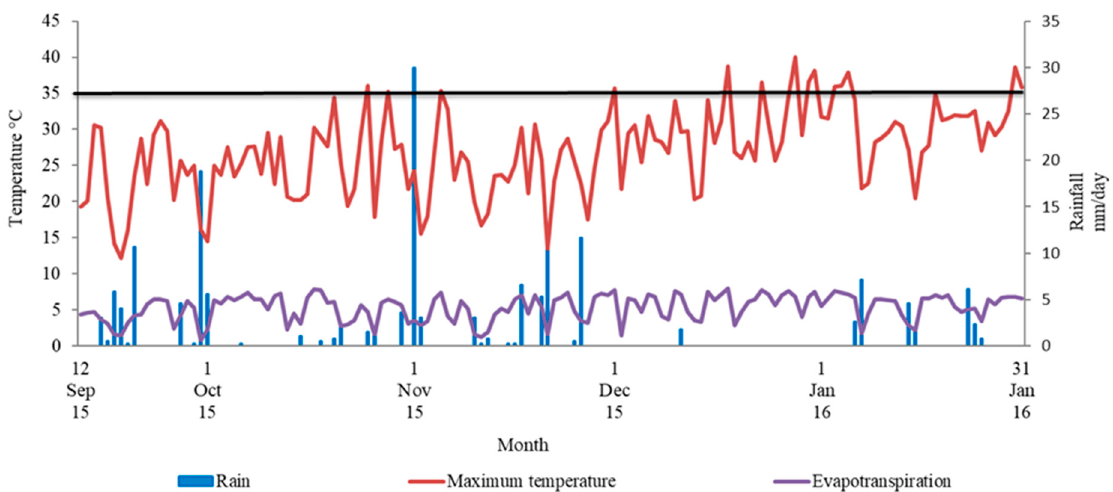
Figure 1. Maximum temperature, rainfall and evapotranspiration from September 2015 to January 2016 at the University of Fort Hare Research Farm, Alice, South Africa. Quality protein maize inbred lines (Table 1) obtained from Quality Seeds (PTY) LTD, South Africa, were used to generate single cross hybrids (SCHs). A total of 10 inbred lines with enough seeds were crossed using the North Carolina mating Design II (NCD II). Table 1. Name, origin and drought stress status of the parental lines. Inbred Line Name